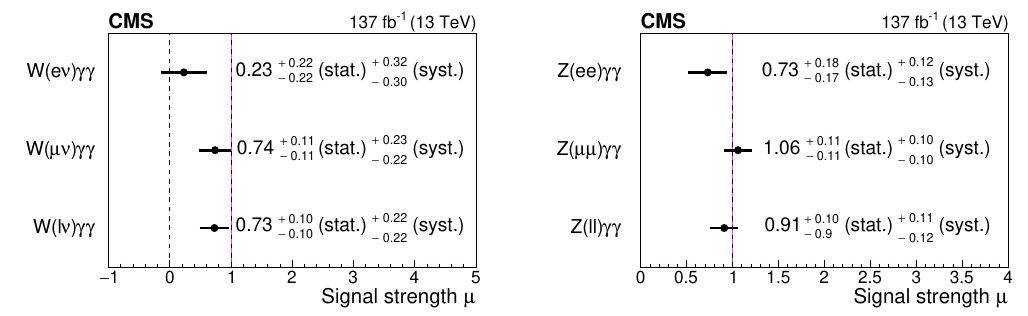
Figure 4 . Best fit values of the signal strengths for the W gg (left) and Z gg (right) channels. The error bars represent the total uncertainty while the magenta bands represent the theoretical uncertainty in the MadGraph 5_a mc@nlo cross